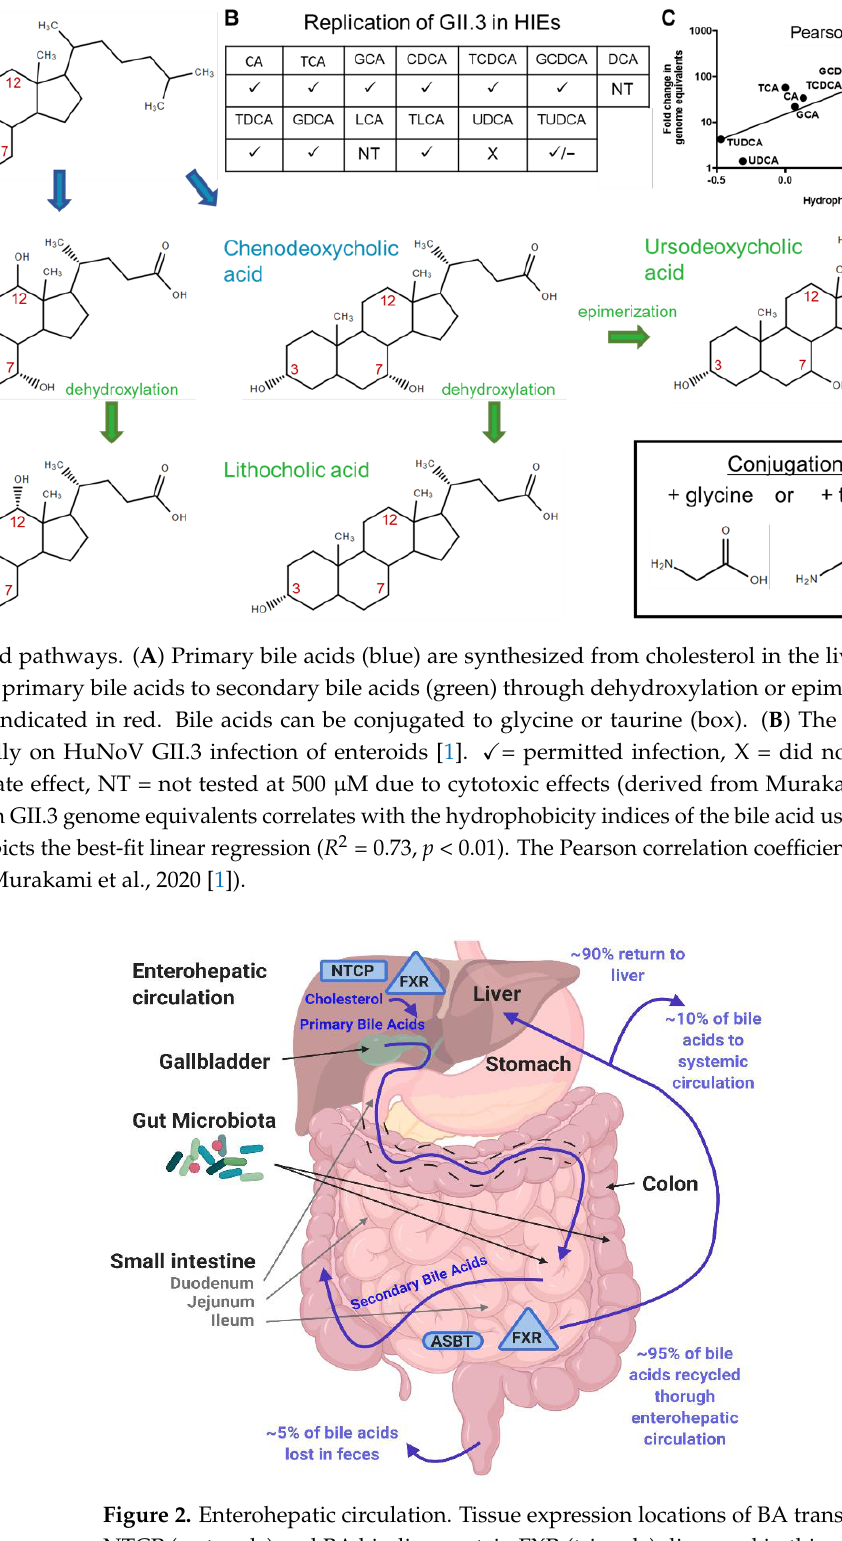
Figure 2. Enterohepatic circulation. Tissue expression locations of BA transporters ASBT (oval)